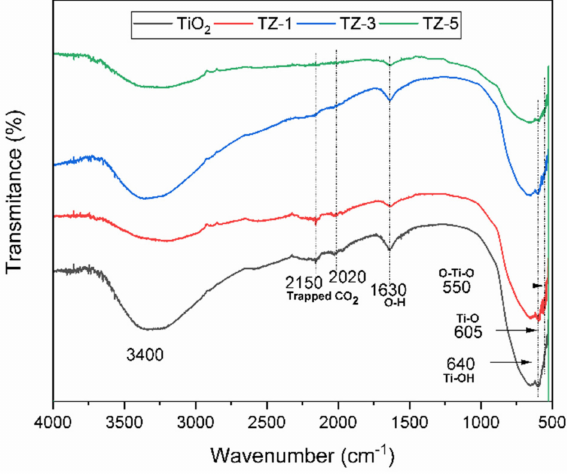
Figure 4. FTIR-ATR spectra for TiO 2 , TZ-1, TZ-3 and TZ-5